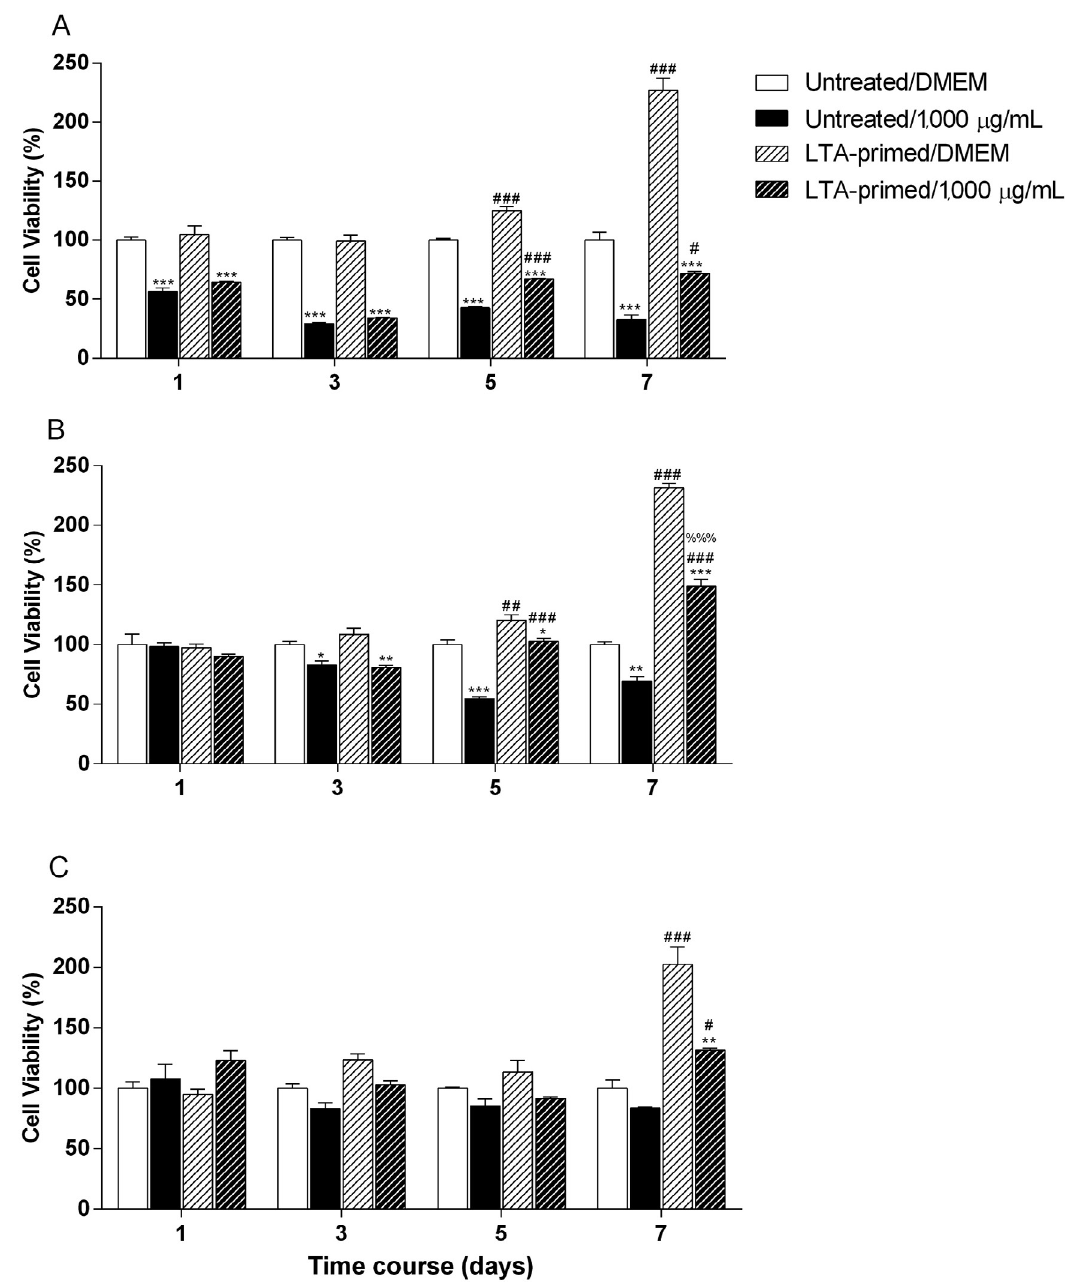
Figure 4- Cytotoxicity of antimicrobials on Untreated and LTA-primed APC. In vitro cytotoxicity of mTAP (A), CMC (B) and mCMC (C) at 1,000 µg/mL tested in contact with untreated or LTA-primed APC for 1, 3, 5 and 7 days. Cell viability detected by MTT and normalized based on control (Untreated/DMEM) cells. *p<.05, **p<.01 and ***p<.001 in comparison to the respective cell condition with culture medium alone (0) or # in comparison to the respective stimuli on untreated cells and % compared to untreated cells under medium alone